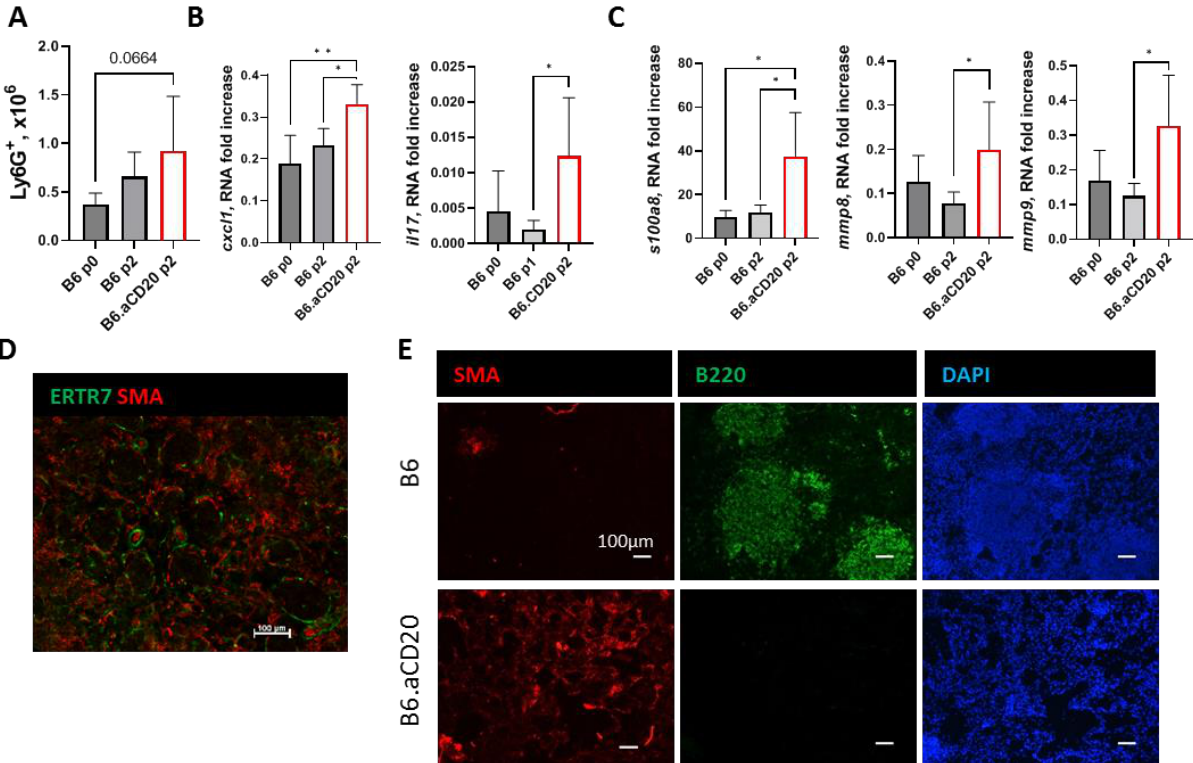
Figure 5. B-cell depletion leads to an increase in expression of genes for neutrophil-associated fac- tors and promotes fibrosis in the lung tissue. ( A ) The content of Ly6G + neutrophils in the lungs of control and B-cell-depleted mice. ( B , C ) Expression of genes for neutrophil-recruiting factors CXCL1 and IL-17 ( B ) and neutrophil-produced pathology-associated factors MMP8, MMP9, and S100A8 in the lungs. Gene expression was normalized to that of hprt . Data from one of two similar experiments are displayed as mean ± SD, 4 – 5 mice per group per time-point. * p < 0.05; ** p < 0.01. ( D ) Fibrosis development in the lungs of TB-susceptible I/St mice at week 9 post-infection with M. tuberculosis H37Rv as assessed by staining with anti-SMA (red) and anti-ER-TR7 (green). ( E ) Non-fibrotic B-cell-rich areas (green) in control B6 animals (upper panels) and fibrotic, SMA-positive fibrotic areas (red) in the lungs of B-cell-depleted at the p2 (lower panels). See text for details.